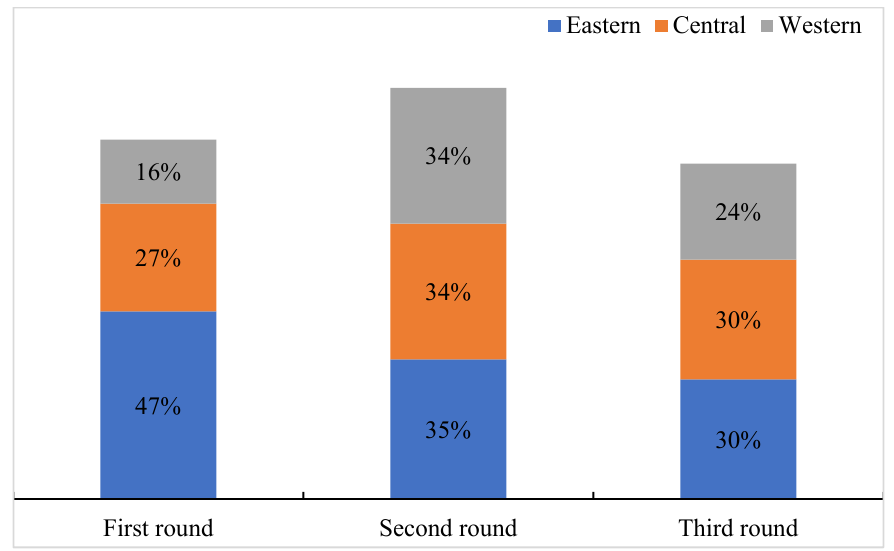
Figure 7. The proportion of different regions in three rounds of smart city construction in China [28].